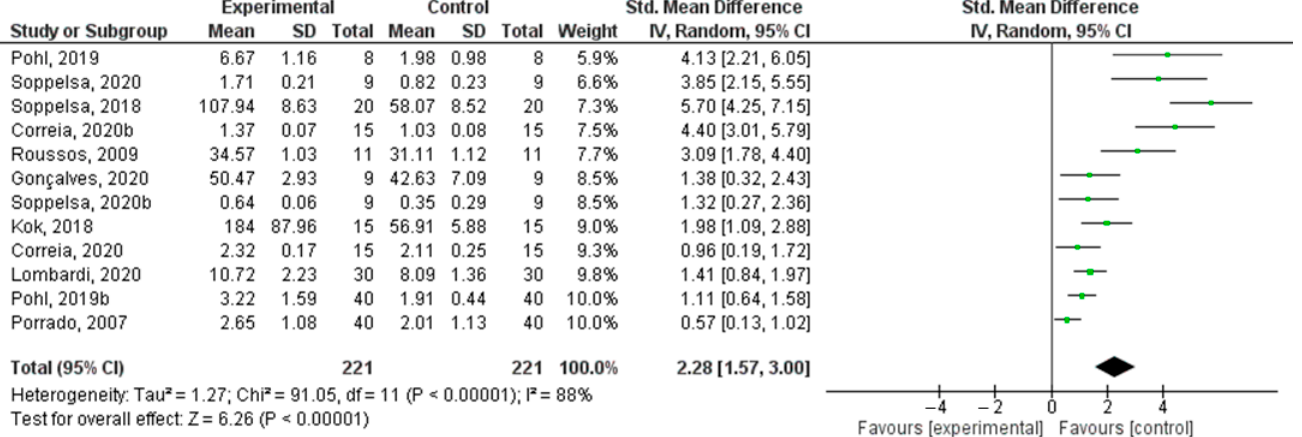
Figure 6. Forest plot for the effects of biostimulant application on anthocyanin content of the analyzed studies [15,222–230], plotted according to the standard mean difference. The weight of each study is represented by the size of the green box. The forest plot displays a horizontal line that indicates the lower and upper limits of the 95% confidence interval (CI) of the effect reported for each study. The vertical line represents the no-effect, and if it crosses the horizontal lines it indicates the non-significance of the data reported in the respective study. The black diamond at the bottom represents the average effect size. Heterogeneity was assessed using I 2 statistical test, that represents the amount of total variation that could be attributed to heterogeneity. The figure was generated by Review Manager Software, ver. 5.4.1.